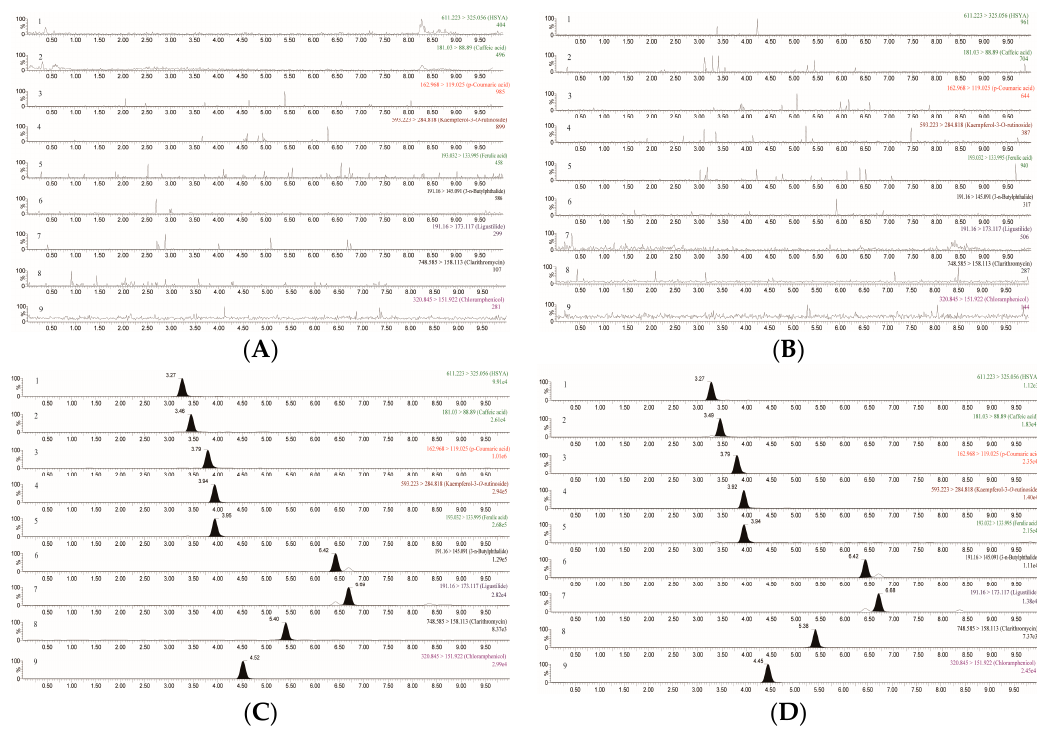
Figure 1. Typical MRM chromatograms of the seven components in rats: ( A ) blank plasma sample from a normal rat; ( B ) blank plasma sample from a model rat; ( C ) blank plasma samples spiked with standard mixtures and internal standards; and ( D ) ratplasma samples collected after oral administration of Gui-Hong extracts. Note: hydroxysafflor yellow A ( 1 ), caffeic acid ( 2 ), p -coumaric acid ( 3 ), kaempferol-3- O -rutinoside ( 4 ), ferulic acid ( 5 ), 3- n -butylphthalide ( 6 ), ligustilide ( 7 ), chloramphenicol ( 8 ), and clarithromycin ( 9 ).